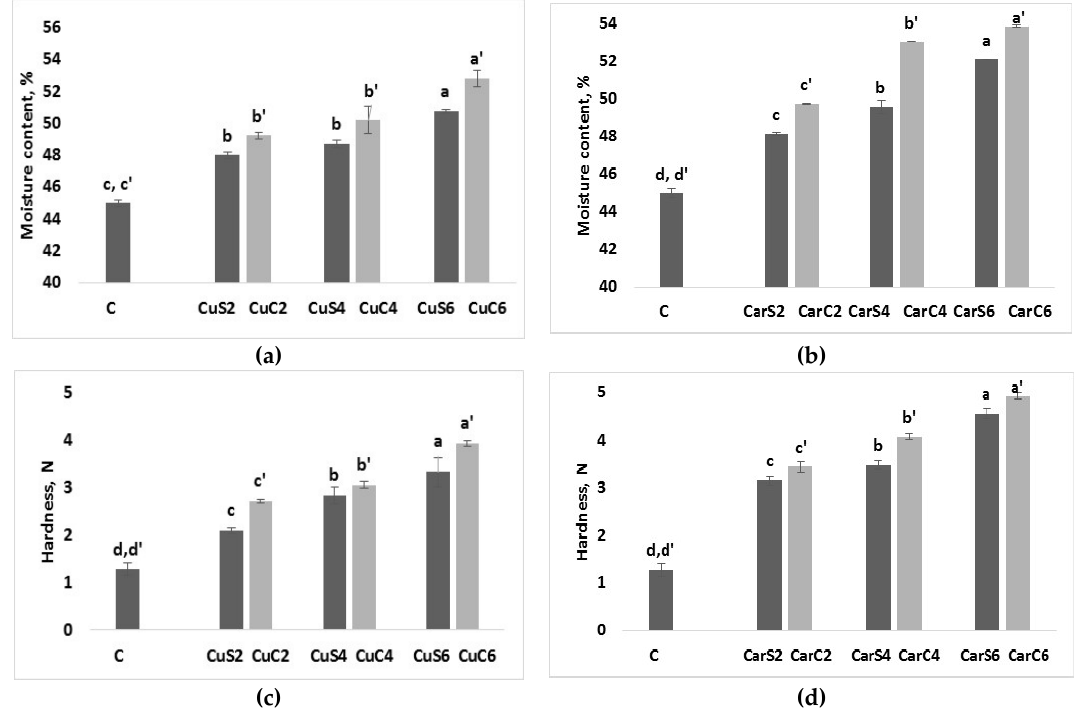
Figure 3. Moisture content (%) and hardness (N) of protein bread fortified with cumin ( a and c ) and caraway ( b and d ) seeds and by ‐ products. CuC2: 2% of cumin cake; CuC4:4% of cumin cake; CuC6: 6% of cumin cake; CuS2: 2% of cumin seed powder; CuS4: 4% of cumin seed powder; CuS6: 6% of cumin seed powder; CarC2: 2% of caraway cake; CarC4: 4% of caraway cake; CarC6: 6% of caraway cake; CarS2: 2% of caraway seed powder; CarS4: 4% of caraway seed powder; CarS6: 6% of caraway seed powder; Columns marked with the same subscript letters in each bar chart are not significantly different ( p > 0.05).